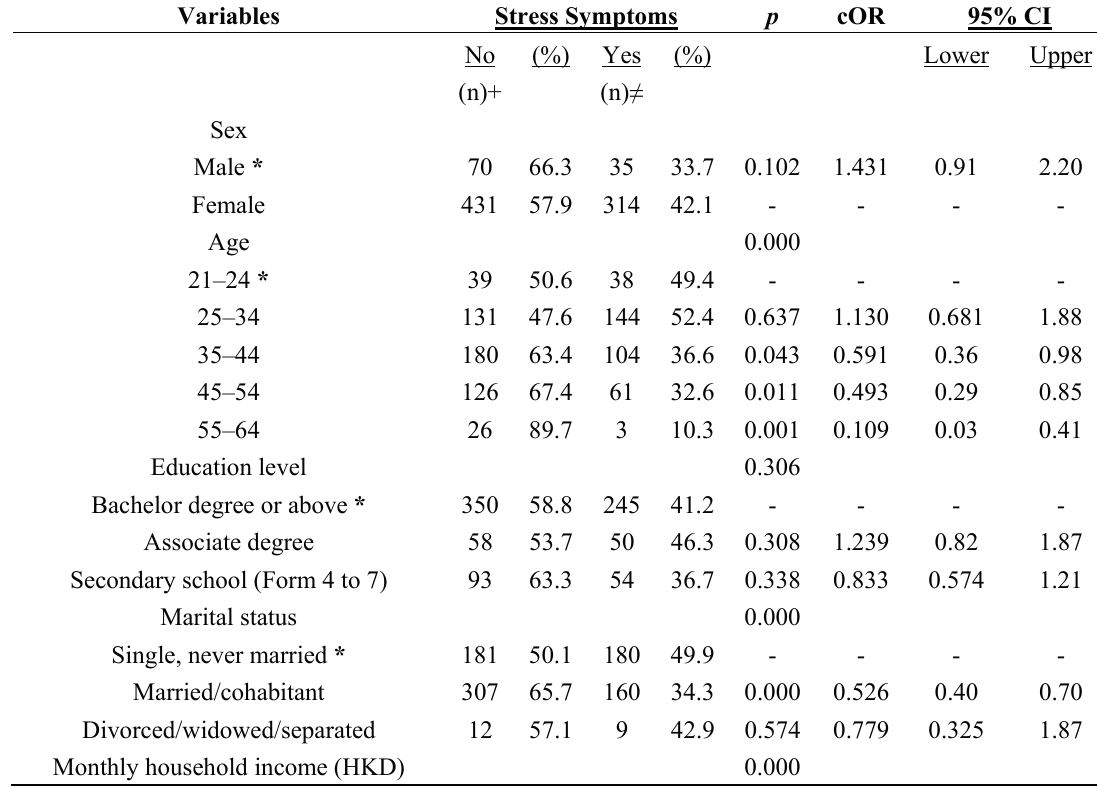
Table 4. Frequency distribution of respondents by stress status and socio-demographic characteristics and other selected